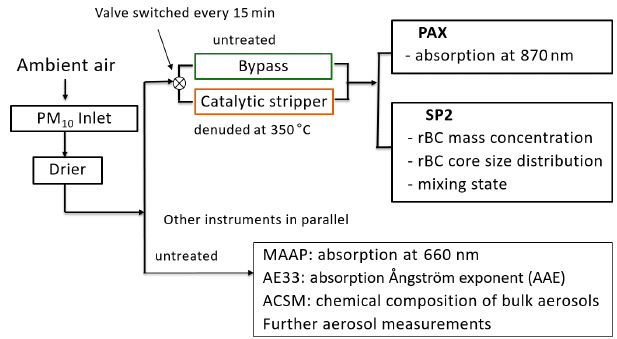
Figure 1. Schematic of the sampling system, instruments and target quantities related to this study. PAX is photoacoustic extinctiome- ter, and SP2 is single-particle soot photometer. PAX and SP2 an- alyzed both ambient and denuded samples. The other instruments only analyzed the untreated ambient aerosol, including a multi- angle absorption photometer (MAAP), an Aethalometer (AE33), an aerosol chemical speciation monitor (ACSM) and further instru- ments, which are not shown